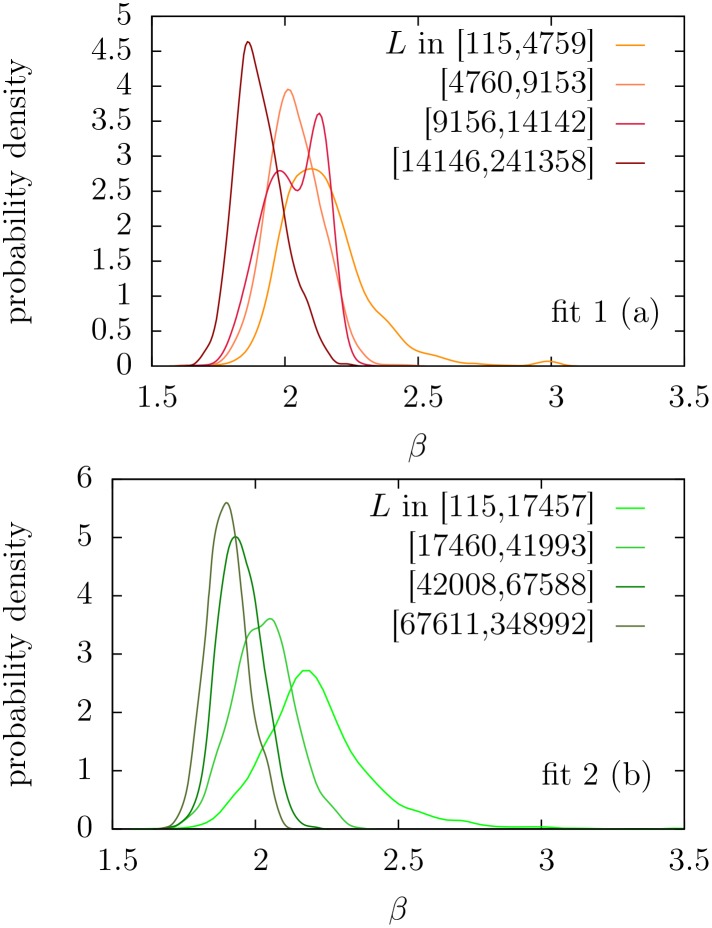
Estimated probability density of β for fits with p ≥ 0.05, in different length ranges.We have divided both groups of accepted texts into 4 percentiles according to L. As in the previous figure, the normal kernel smoothing method is applied. (a) For distribution f1. (b) For distribution f2.